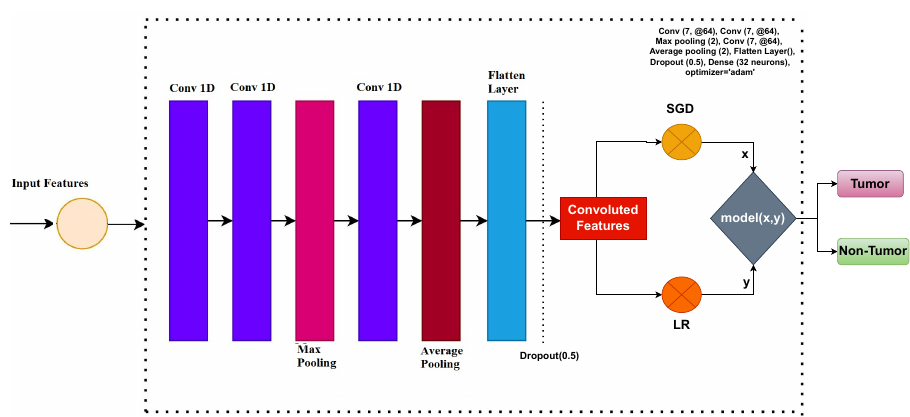
Figure 1. Architecture diagram of the CNN with voting classifier (LR+SGD) model.